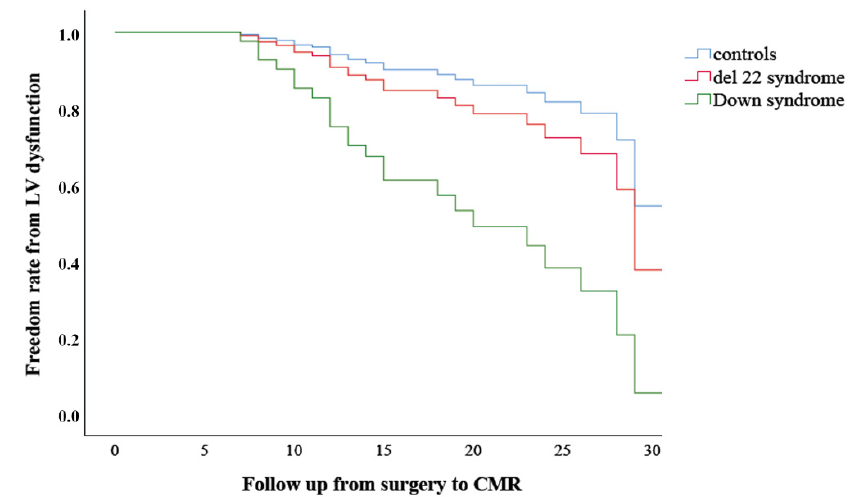
Figure 1. Legend. Multivariate Cox regression analysis for left ventricular (LV) dysfunction development adjusted for age at first repair.